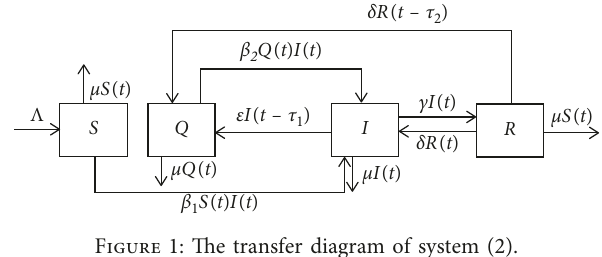
Figure 1: The transfer diagram of system